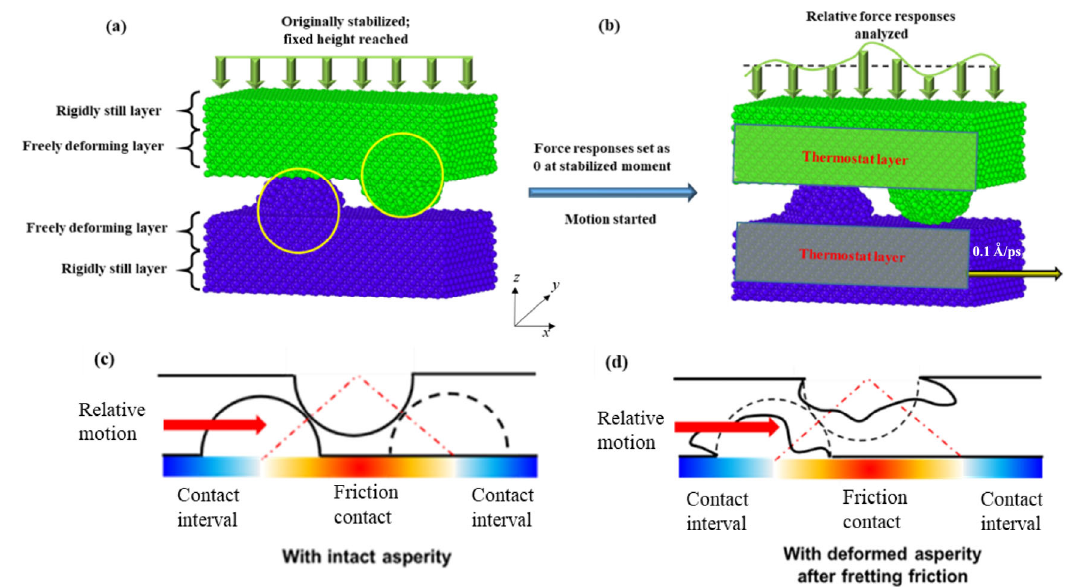
Fig. 1 Illustration of the MD simulation of the fretting interface and friction process: (a) the fretting interfaces model and simulation settings, (b) simulation conditions when the motion is started (diamond–diamond fretting interface as an example)/illustration of the friction contact intervals, (c) with intact asperities, and (d) contact surface deformation after the fretting